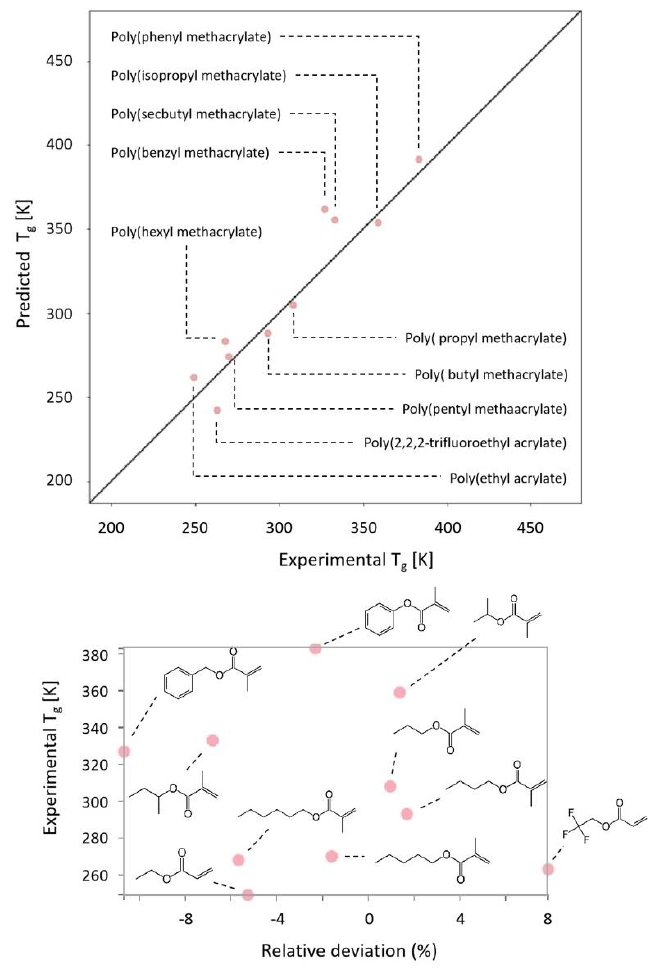
Figure 2. Predicted vs. experimental glass transition values obtained from the trained ANN on the external control group of acrylates. Relative deviations are shown below with the corresponding monomeric chemical structures.